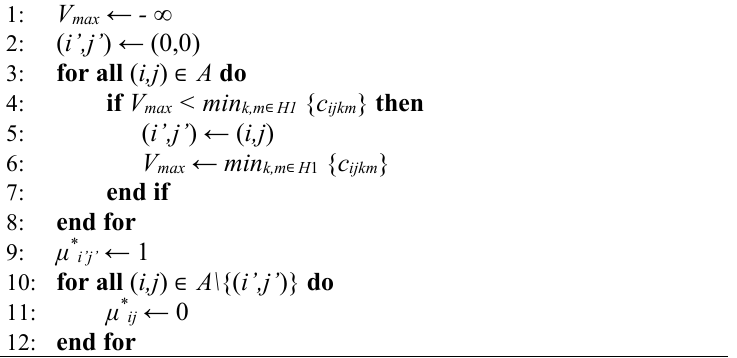
Algorithm 1 : Determining the optimal values of the μ